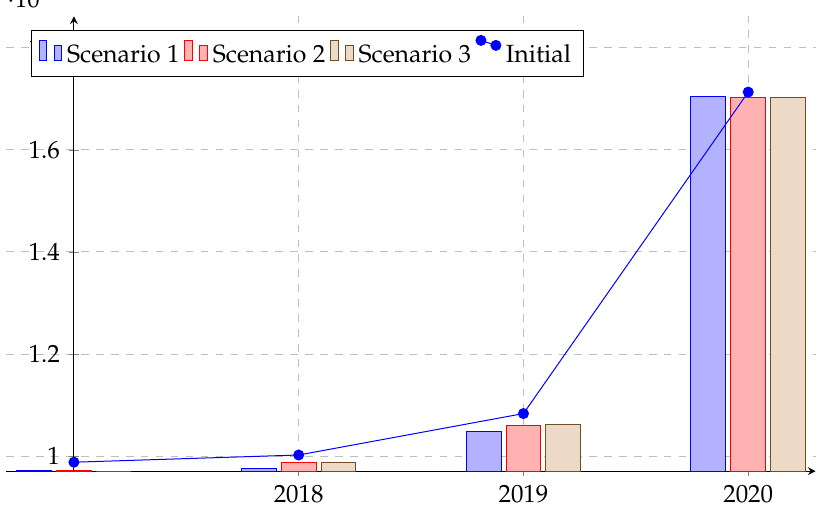
Figure 7. Annual financial